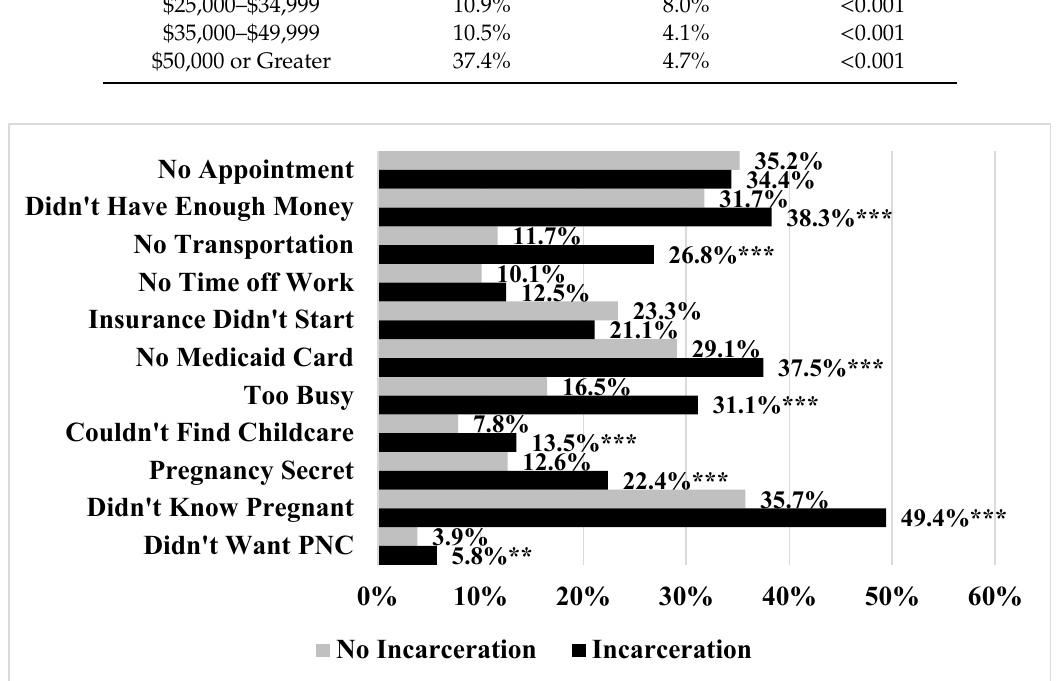
Figure 1. Prevalence of Specific Barriers to Prenatal Care Stratified by Incarceration ( N = 34,658). *** p < 0.001, ** p < 0.01, * p < 0.05.